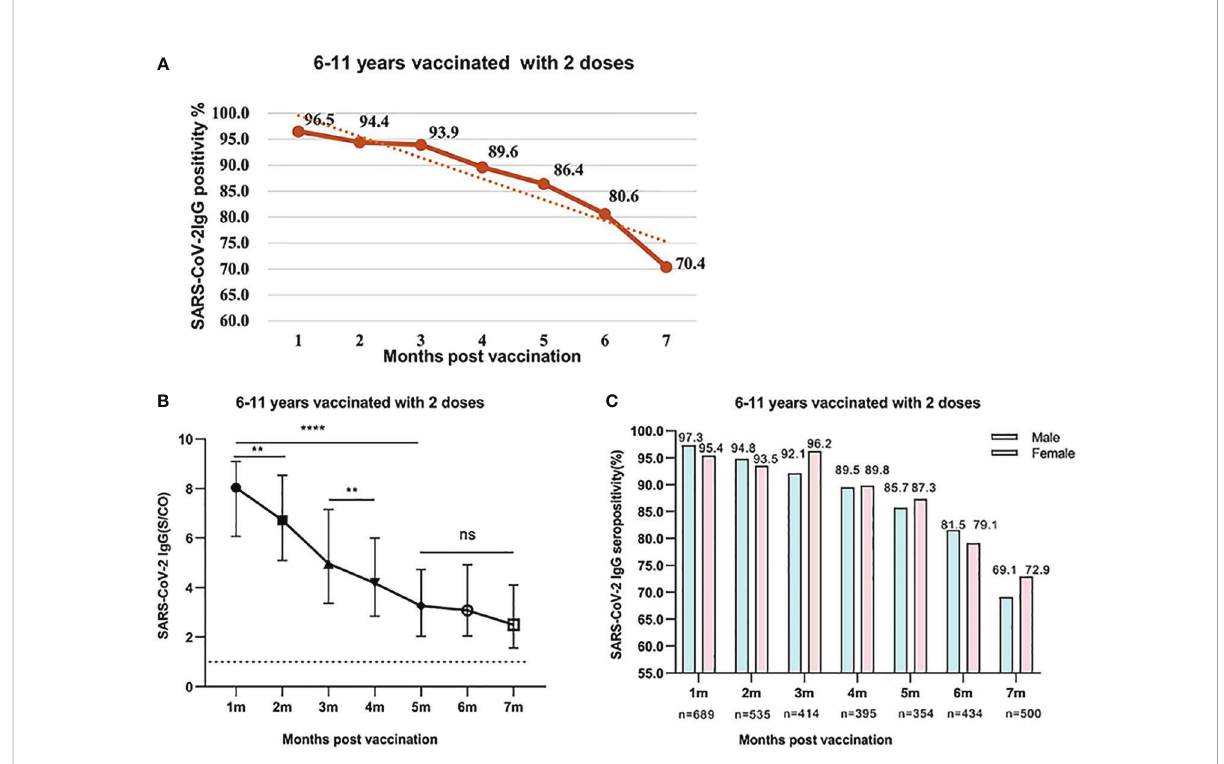
FIGURE 2 (A) SARS-CoV-2 IgG seropositivity in participants who were aged 6-11 years old and were vaccinated with two doses of vaccines after 1-7 months. Data were presented as percentage. (B) SARS-CoV-2 IgG levels in participants who were aged 6-11 years and were vaccinated with two doses of inactivated SARS-CoV-2 vaccines after 1-7 months. Data were expressed as median (interquartile range) and analyzed using the Mann ‐ Whitney U test. The positive levels of SARS-CoV-2 IgG antibody showed a signi fi cant difference among different periods after vaccination (P<0.001). The signs represent median values, and the bands represent interquartile ranges [1 month, 8.039 (6.067-9.098); 2 months, 6.721 (5.094-8.540); 3 months, 4.968 (3.368-7.156); 4 months, 4.183 (2.838-5.998); 5 months, 3.259 (2.03-4.731); 6 months, 3.08 (2.048-4.924); 7 months, 2.492 (1.557-4.116). ns, not signi fi cant, **P<0.01, ****P<0.0001]. (C) Comparison of SARS-CoV-2 IgG seropositivity between male and female participants who were aged 6-11 years old and were vaccinated with two doses of vaccines. Data were expressed as percentage and analyzed using the Chi-square test. The SARS-CoV-2 IgG seropositivity showed no signi fi cant difference between male and female participants. (1 month, c 2 = 2.229, P=0.126; 2 months, c 2 = 0.226, P=0.635; 3 months, c 2 = 2.323, P=0.127; 4 months, c 2 = 0.003, P=0.953; 5 months, c 2 = 0.198, P=0.657; 6 months, c 2 = 0.373, P=0.541; 7 months, c 2 = 0.798,